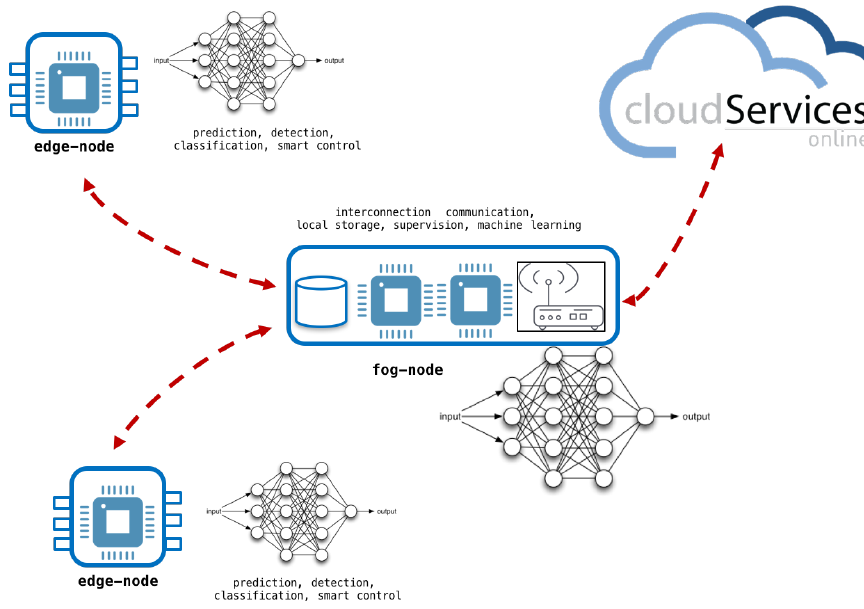
Figure 6. Architecture implemented: services